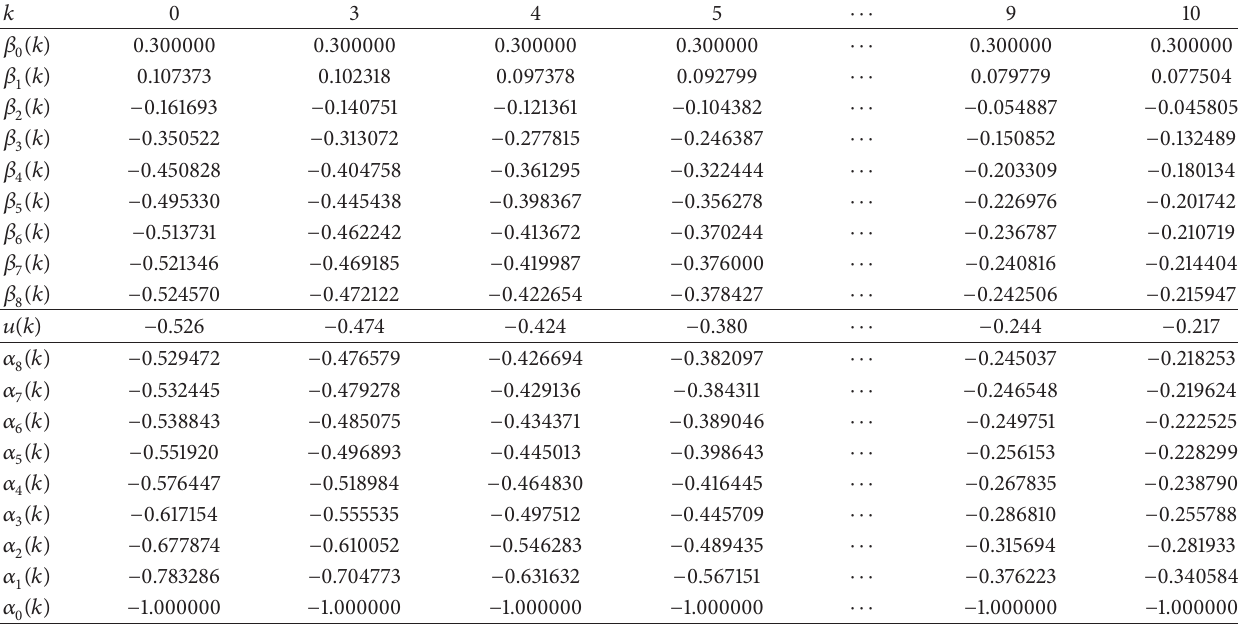
Table 1: Values of the successive lower/upper approximations 𝛼 𝑛 (𝑘) and 𝛽 𝑛 (𝑘) , 𝑛 = 0,1, 2, 3, 4,5, 6, 7, 8